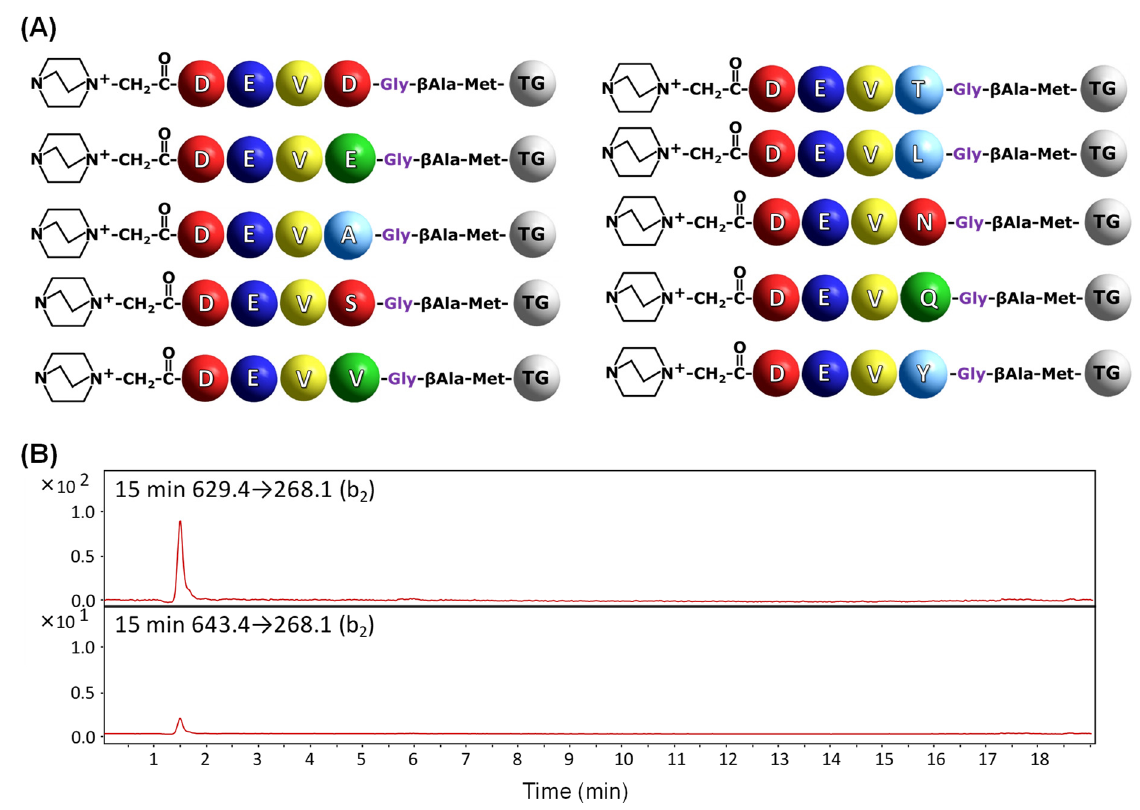
Figure 5. Schematic presentation of model training library for caspase 3 ( A ) and MRM chromatograms ( B ) for QA-DEVD-OH (629.4 → 268.1) and QA-DEVE-OH (643.4 → 268.1) peptides investigated in supernatant after 15 min of enzymatic digestion.